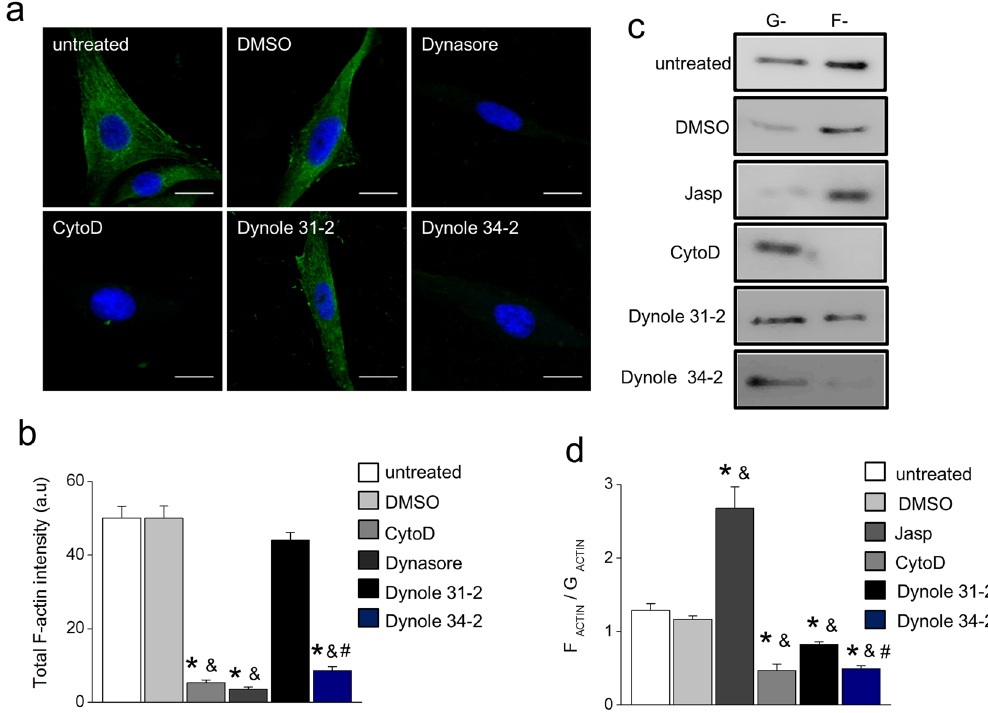
Figure 1. Dynamin GTP-ase activity regulates actin organization in RCMH myoblasts. ( a , b ) Cultured RCMH myoblasts were permeabilized during 6 min with 20 µ M digitonin in the presence of G-actin-AF488, 2 mM ATP/Mg 2 + and 10 µ M free Ca 2 + , fixed and visualized by confocal microscopy. The pharmacological treatments applied during permeabilization were: 20 µ M dynole 34-2, 20 µ M dynole 31-2, 100 µ M dynasore, 4 µ M CytoD or the vehicle DMSO. ( a ) Examples of the formation of actin filaments in RCMH cells under different experimental conditions. Scale bar = 10 µ m. ( b ) Quantification of total fluorescence intensity of new actin filaments. Note that dynamin GTP-ase inhibitors significantly reduce actin filament formation. Data are expressed as mean actin intensity ± SEM. Statistical comparisons were performed utilizing a two-tail t-test Welch corrected for parametric data. The symbols * , & and # denote significance compared to untreated, DMSO-treated and dynole 31-2-treated cells, respectively. N is between 15 and 28 cells, from at least three different cultures per condition. ( c , d ) Plated myoblasts were incubated during 15 min at 37 °C with 2 µ M of the F-actin stabilizer jasplakinolide (Jasp), 4 µ M CytoD, 20 µ M dynole 34-2, 20 µ M dynole 31-2 or the vehicle DMSO, then lysed with an actin- stabilizing buffer and ultracentrifuged to separate G- and F-actin. Samples were electrophored in 12% SDS- PAGE and developed by western blot with an anti-actin antibody; although not necessarily at the same time, all gels were run under the same experimental conditions. ( c ) Representative blots for G- and F-actin under different treatments. These are cropped images; full-length blots are shown in the Supplementary Fig. S1. ( d ) Quantification of band densities. Note that the F/G actin ratio increases in the presence of Jasp, while decreases in the presence of CytoD, as compared to DMSO-treated or untreated cells. Dynole 34-2 significantly reduced F/G ratio compared to its inactive analogue dynole 31-2. Data are expressed as means ± SEM from at least three different cultures per condition. Statistical comparisons were performed utilizing a two-tail Mann-Whitney non-parametric test. The symbols * , & and # denote significance compared to untreated, DMSO-treated and dynole 31-2-treated cells,